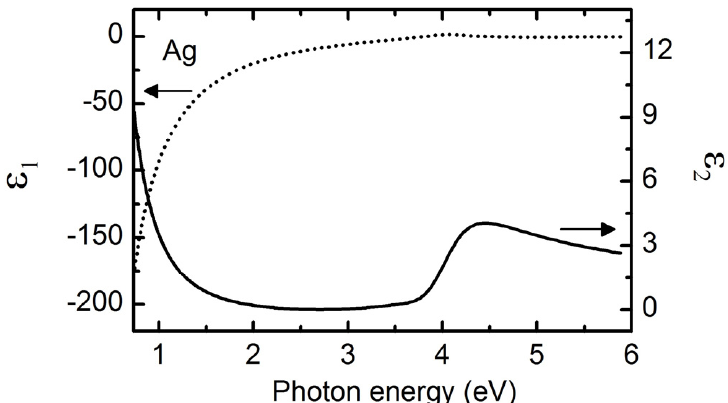
Figure 1. Complex dielectric function spectra, ε = ε 1 + i ε 2 , (arrow pointing left for ε 1 axis, arrow pointing right for ε 2 axis) from 0.734 to 5.88 eV for a semi-infinite Ag film parameterized with a combination of a Drude oscillator and two oscillators assuming critical point parabolic bands (CPPB) with parameters listed in Table 2. Table 2. Parameters describing complex dielectric function ( ε = ε 1 + i ε 2 ) and structure for a semi ‐ infinite Ag film on a borosilicate glass over coated by Cr before ZnO deposition. Experimental ellipsometric spectra were collected in situ after deposition at room temperature in the spectral range from 0.734 to 5.88 eV and fit using least square regression analysis with an unweighted estimator error function, = 5 × 10 − 3 . For bulk Ag, the parameterization of ε consisted of a Drude oscillator, two oscillators assuming critical point parabolic bands (CPPB), and a constant additive term to ε 1 denoted ε . Spectra in ε for the 30 ± 2 Å surface roughness layer were parameterized with two Lorentz oscillators and ε = 1.